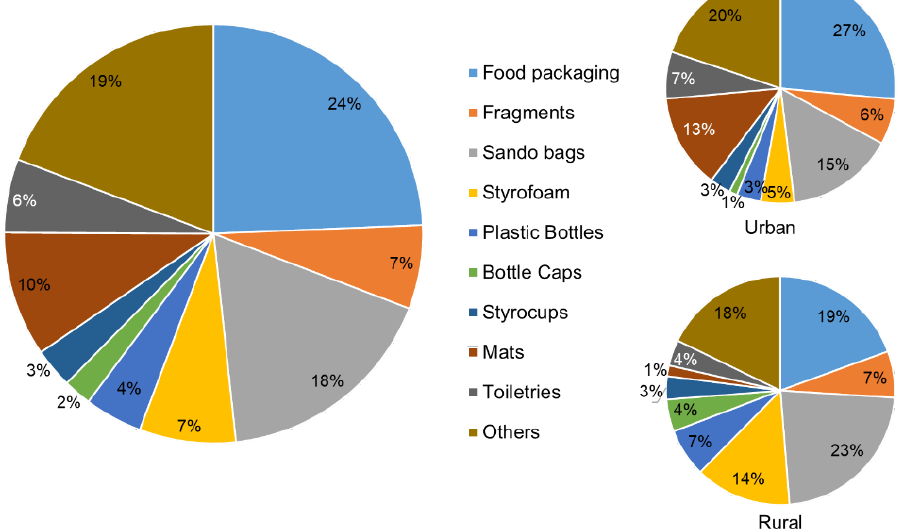
Figure 3. Types of macroplastic litter in rural and urban beaches in Sarangani Bay, Philippines.